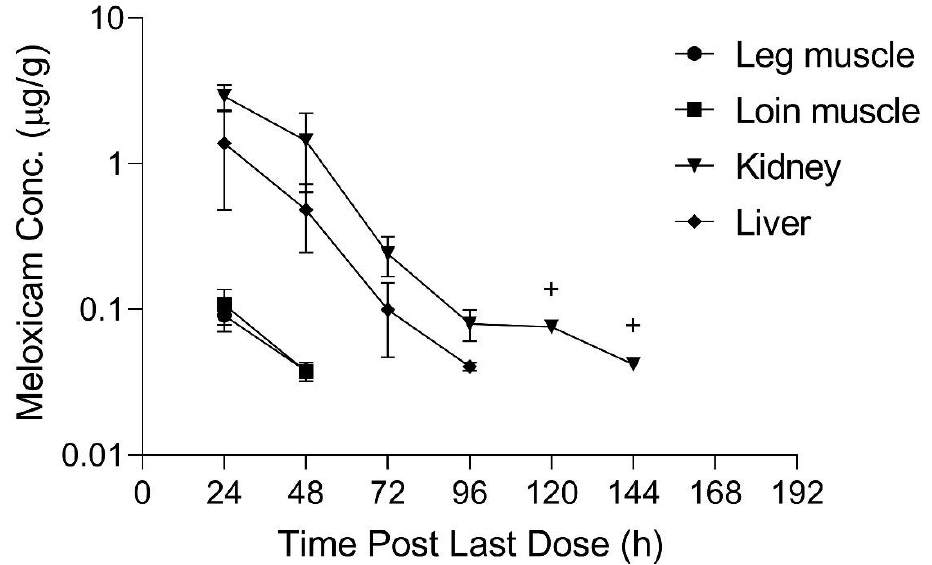
Figure 4. Mean tissue meloxicam concentrations (+SD) sampled over time (0 – 192 h) for sheep after ad- ministration of 10 daily oral 1 mg/kg doses of meloxicam dissolved in water. N = 3 sheep per time point at 24, 72, 96, 120, 144 h and n = 6 at 48 h, 21 total sheep. Values below the lower limit of quantitation or limit of detection are excluded. Single data point indicated by +, therefore no SD bars provided.